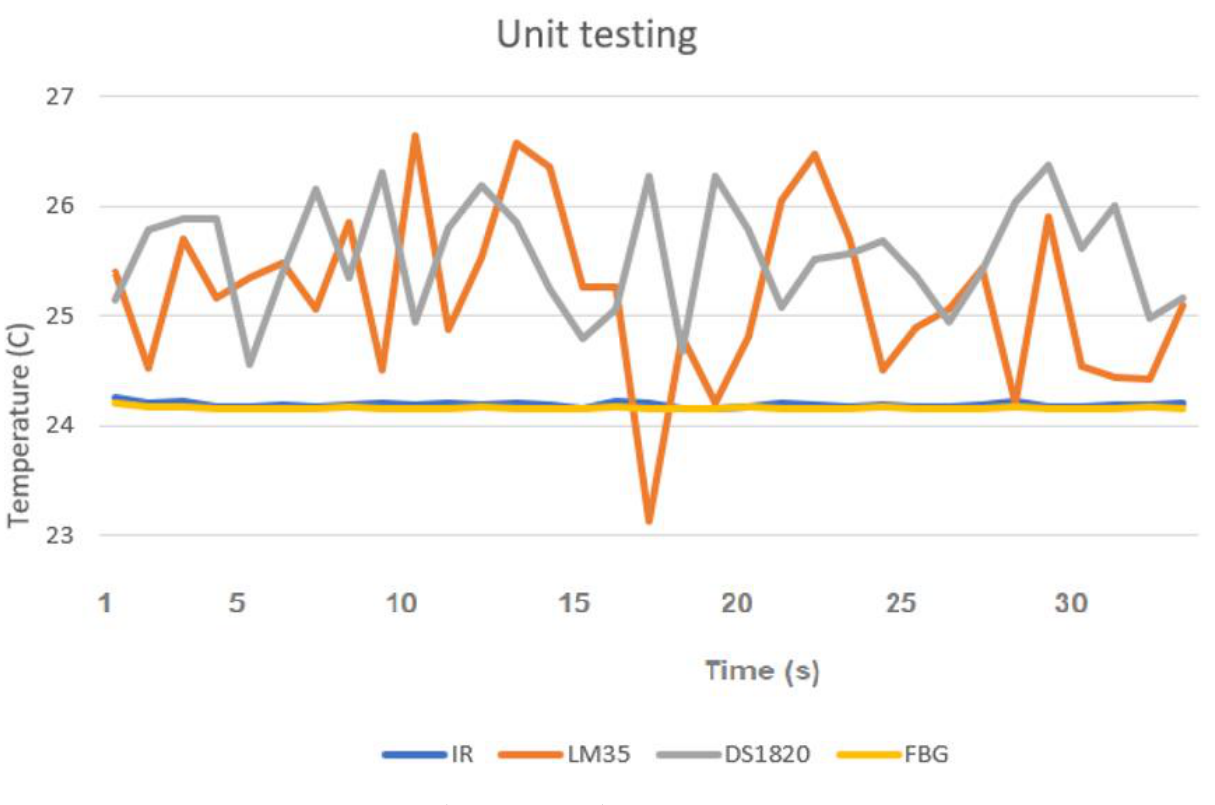
Figure 7. Normal operating conditions at PPC. Table 2. Statistics of the measurements at PCC